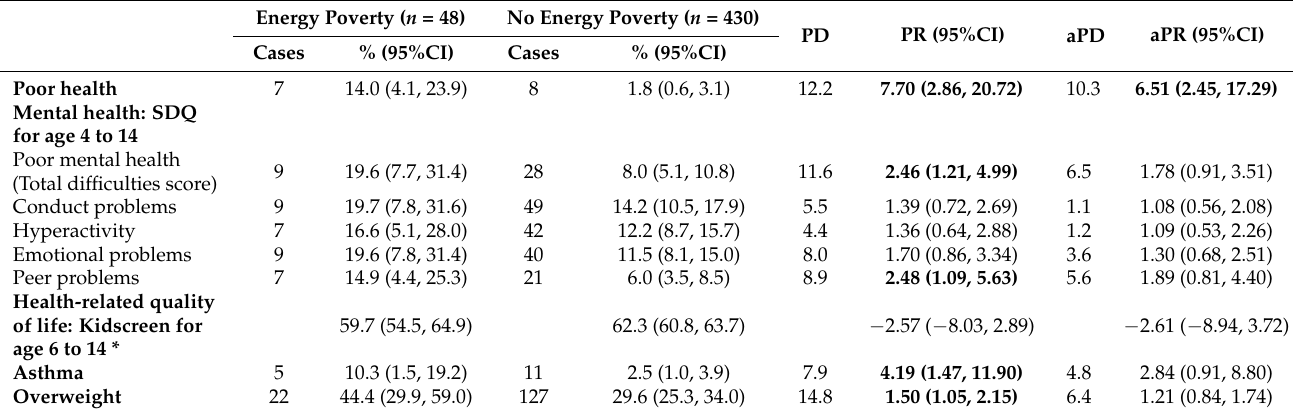
Table 2. Health measures prevalence among children with and without energy poverty and crude and adjusted absolute (prevalence difference—PD) and relative (prevalence ratio—PR) differences. Barcelona